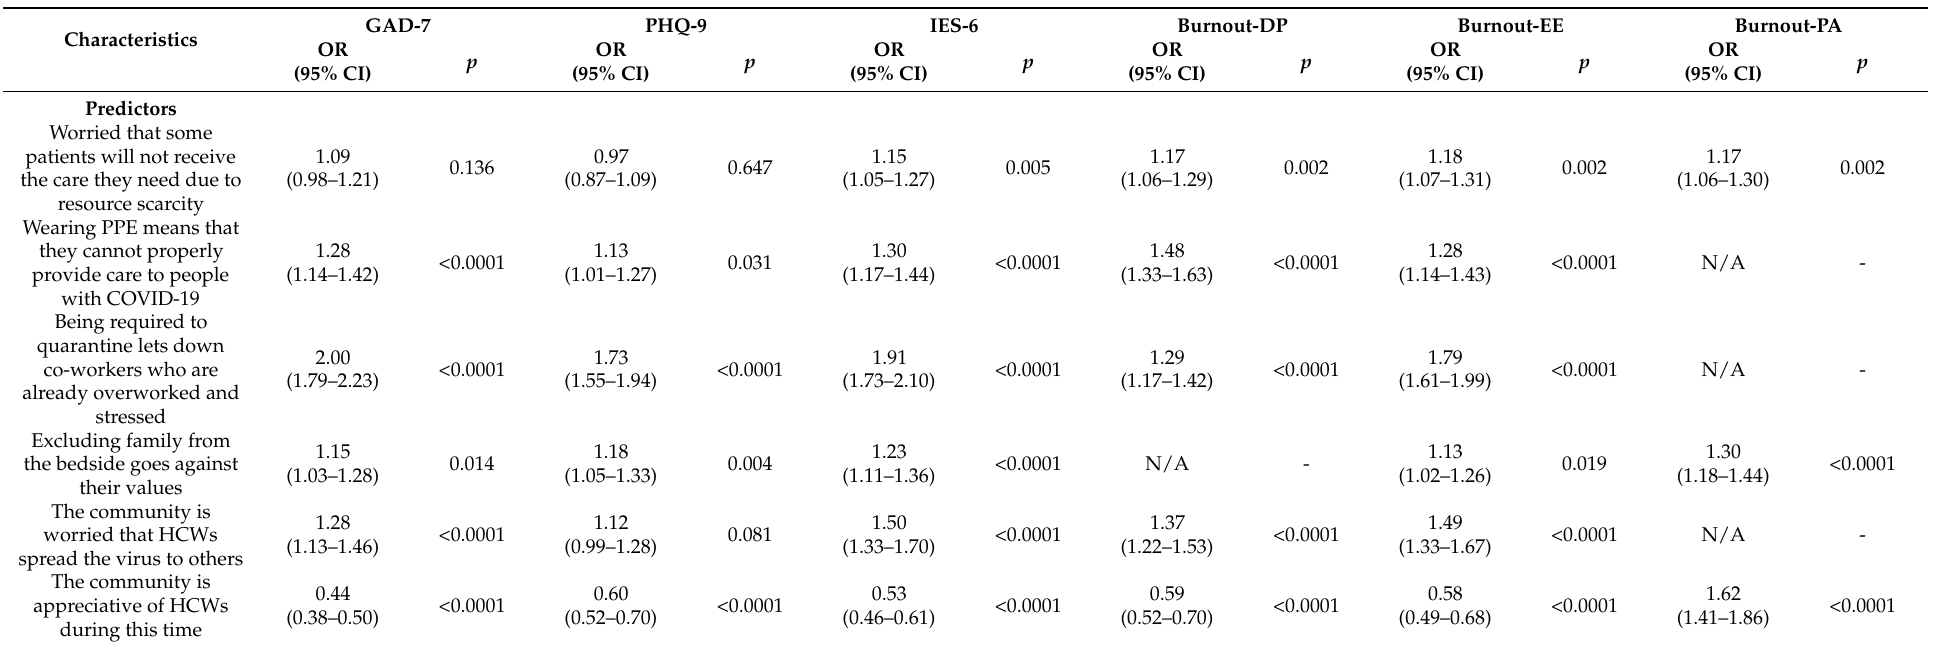
Table 4. Relationship between moral distress and mental health outcomes (multivariate